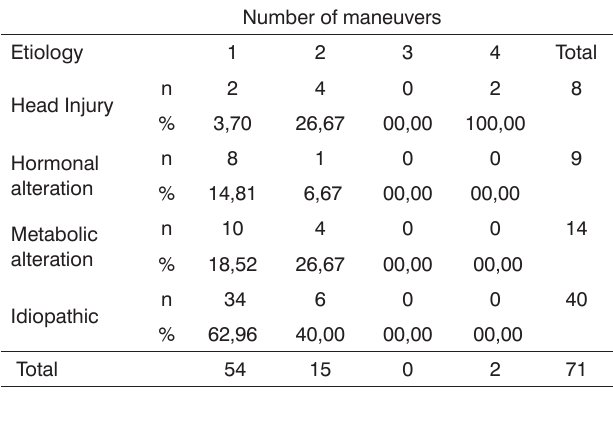
Table 3. Crossing the number of maneuvers and etiology variables Number of